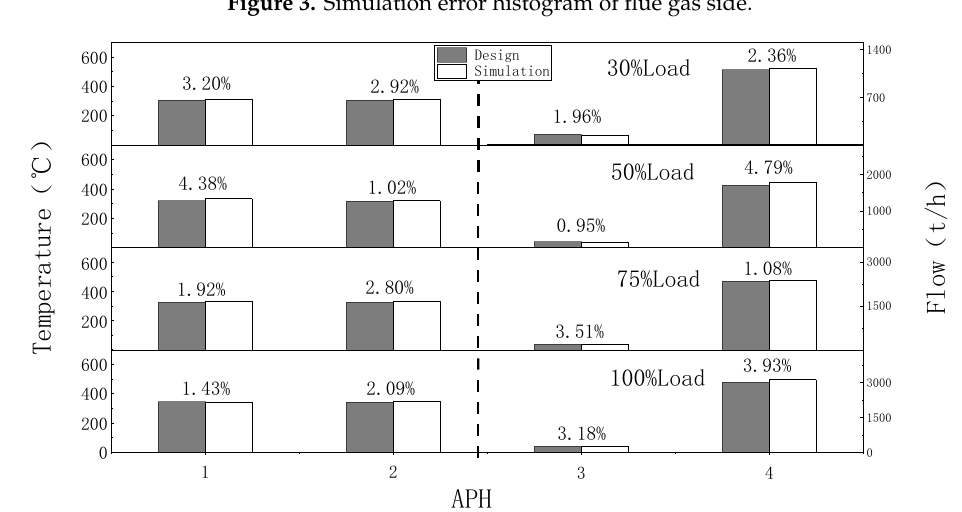
Figure 3. Simulation error histogram of flue gas side.